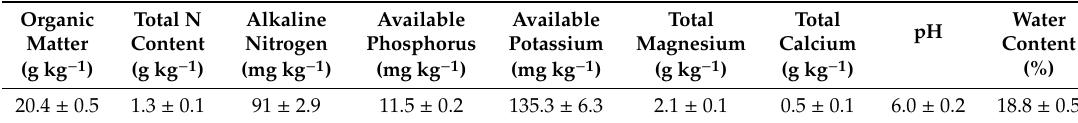
Table 2. The main physical and chemical properties of soils Organic Total N Alkaline Available Matter Content Nitrogen Phosphorus